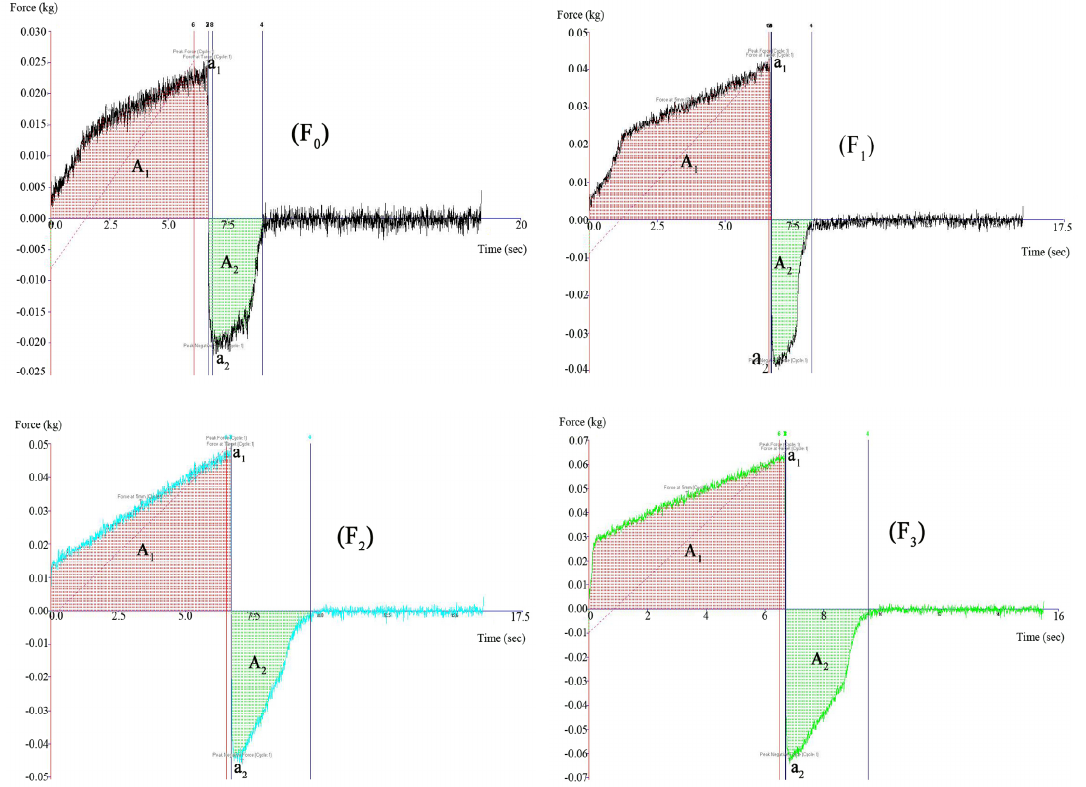
: Thermosensitive composite 0